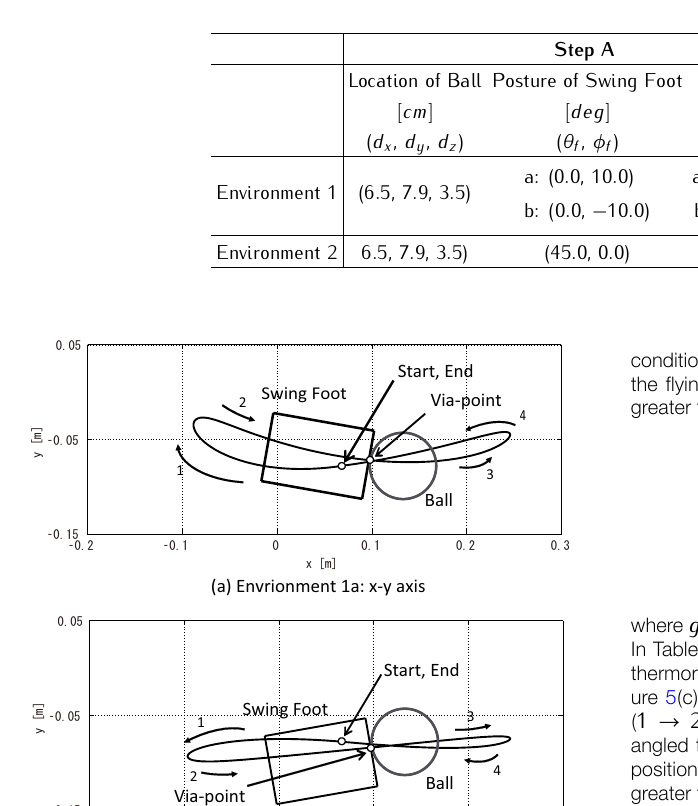
Table 1. Conditions of experimental environments. The values with superscript ∗ in Step B indicate optimal velocities. In Environment 1 of Step B, the velocity V y with superscript α is specified value α in Equation (22).